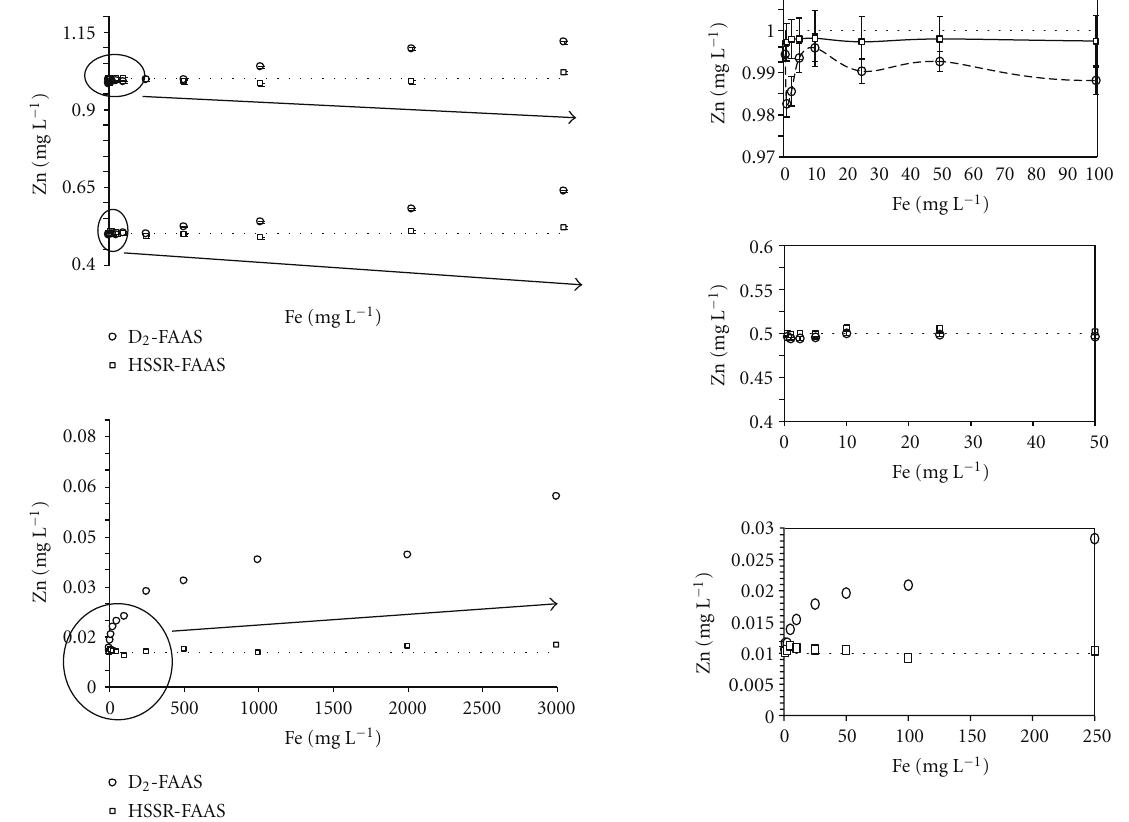
Figure 2: E ff ect of Fe on the three concentrations of Zn (0.01, 0.5, and 1mg L − 1 ) measured in water by FAAS at 213.856 nm with the D 2 and HSSR methods.